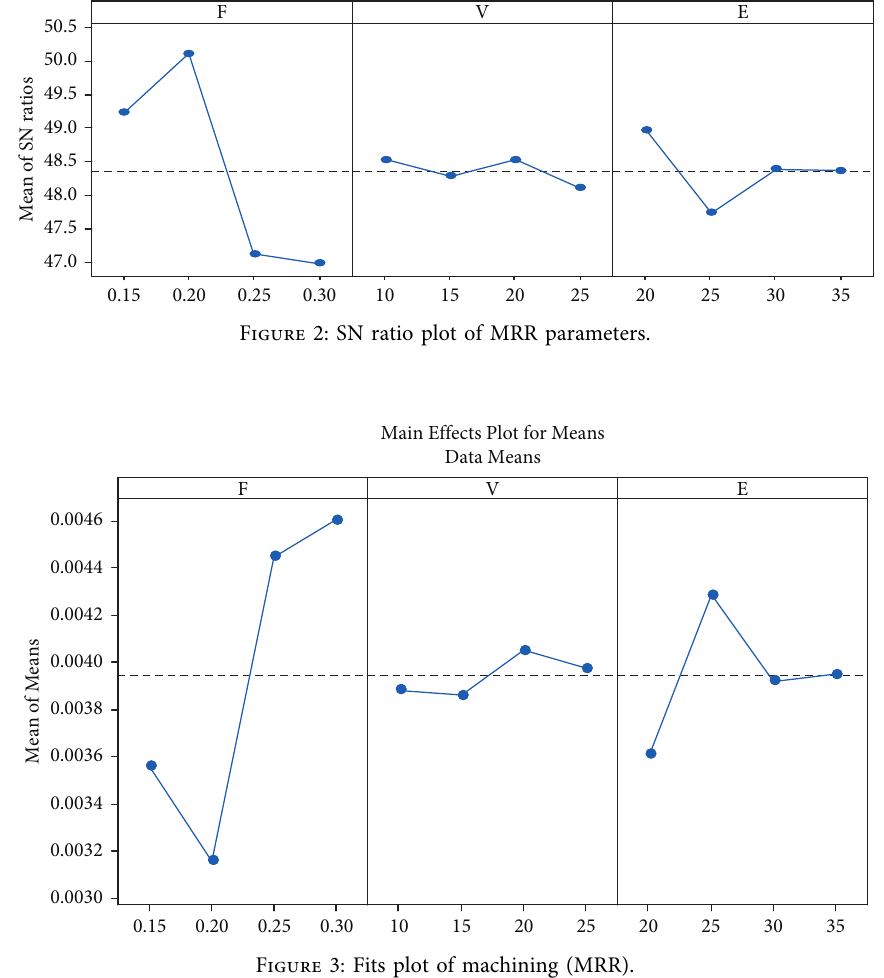
Figure 3: Fits plot of machining (MRR).